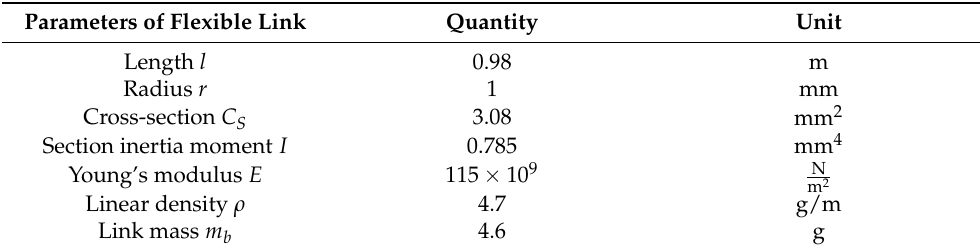
Table 2. Characteristics of the flexible